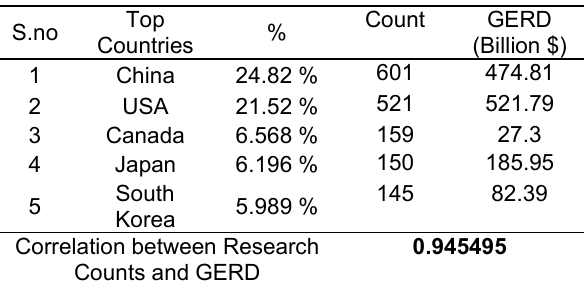
Table 6. Country-wise Research Contributions